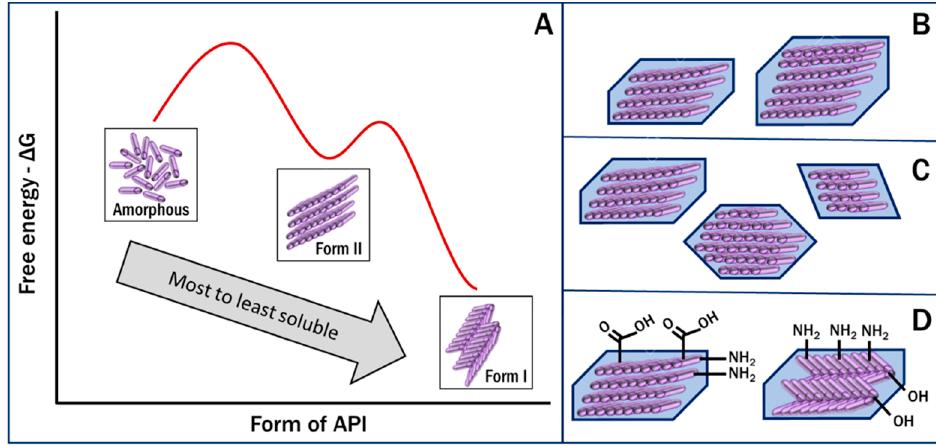
Figure 2. Key factors affecting the dissolution rate of pharmaceuticals. ( A ). free energy of the API form, ( B ). crystal size, ( C ). crystal habit, and ( D ). surface functional groups.